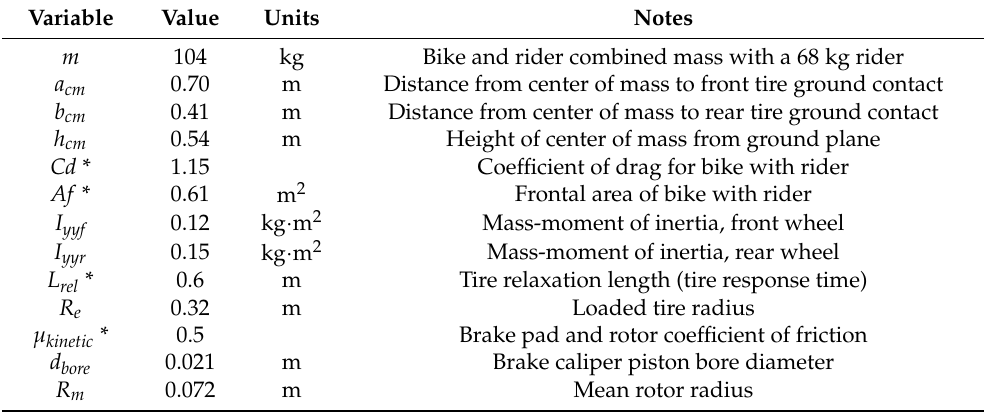
Table 4. Measured and referenced model parameters used for simulating the braking performance of an e-bike.